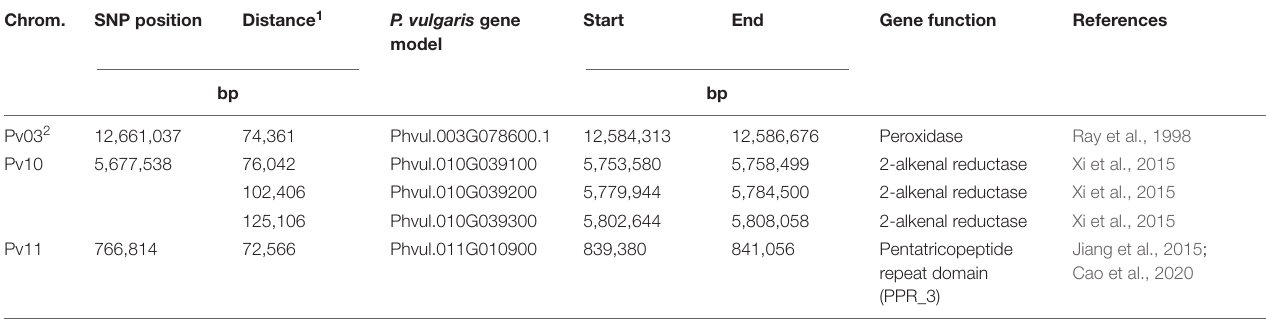
1 Distance between SNP and nearest end of candidate gene. 2 QTN on Pv03 associated with disease severity while those on Pv10 and Pv11 are associated with biomass.